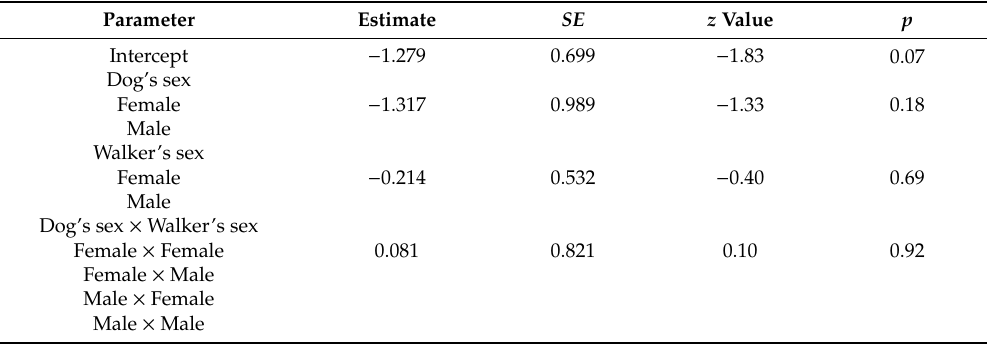
Table 4. E ff ects of sex of dog and sex of walker on likelihood of ground scratching by dogs during a 20-min